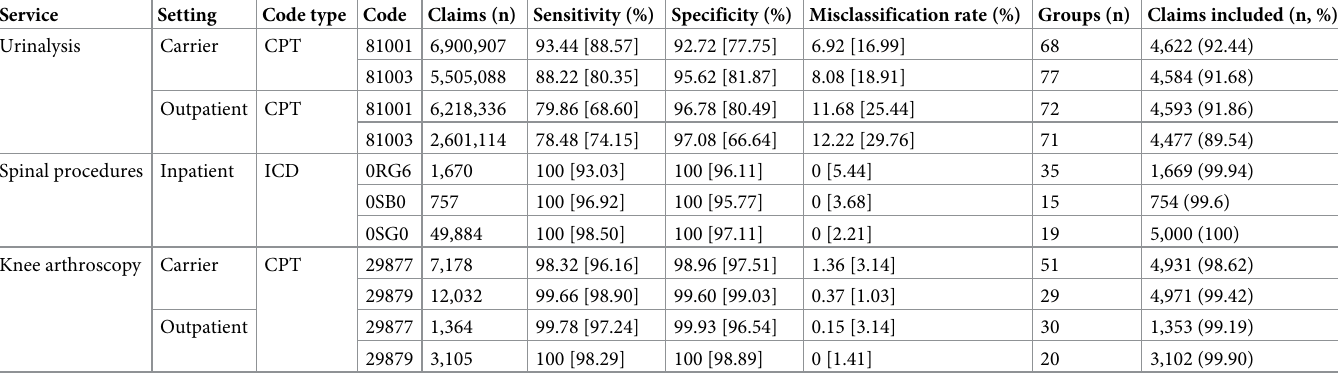
Table 2. Results for the tree classification models for our example